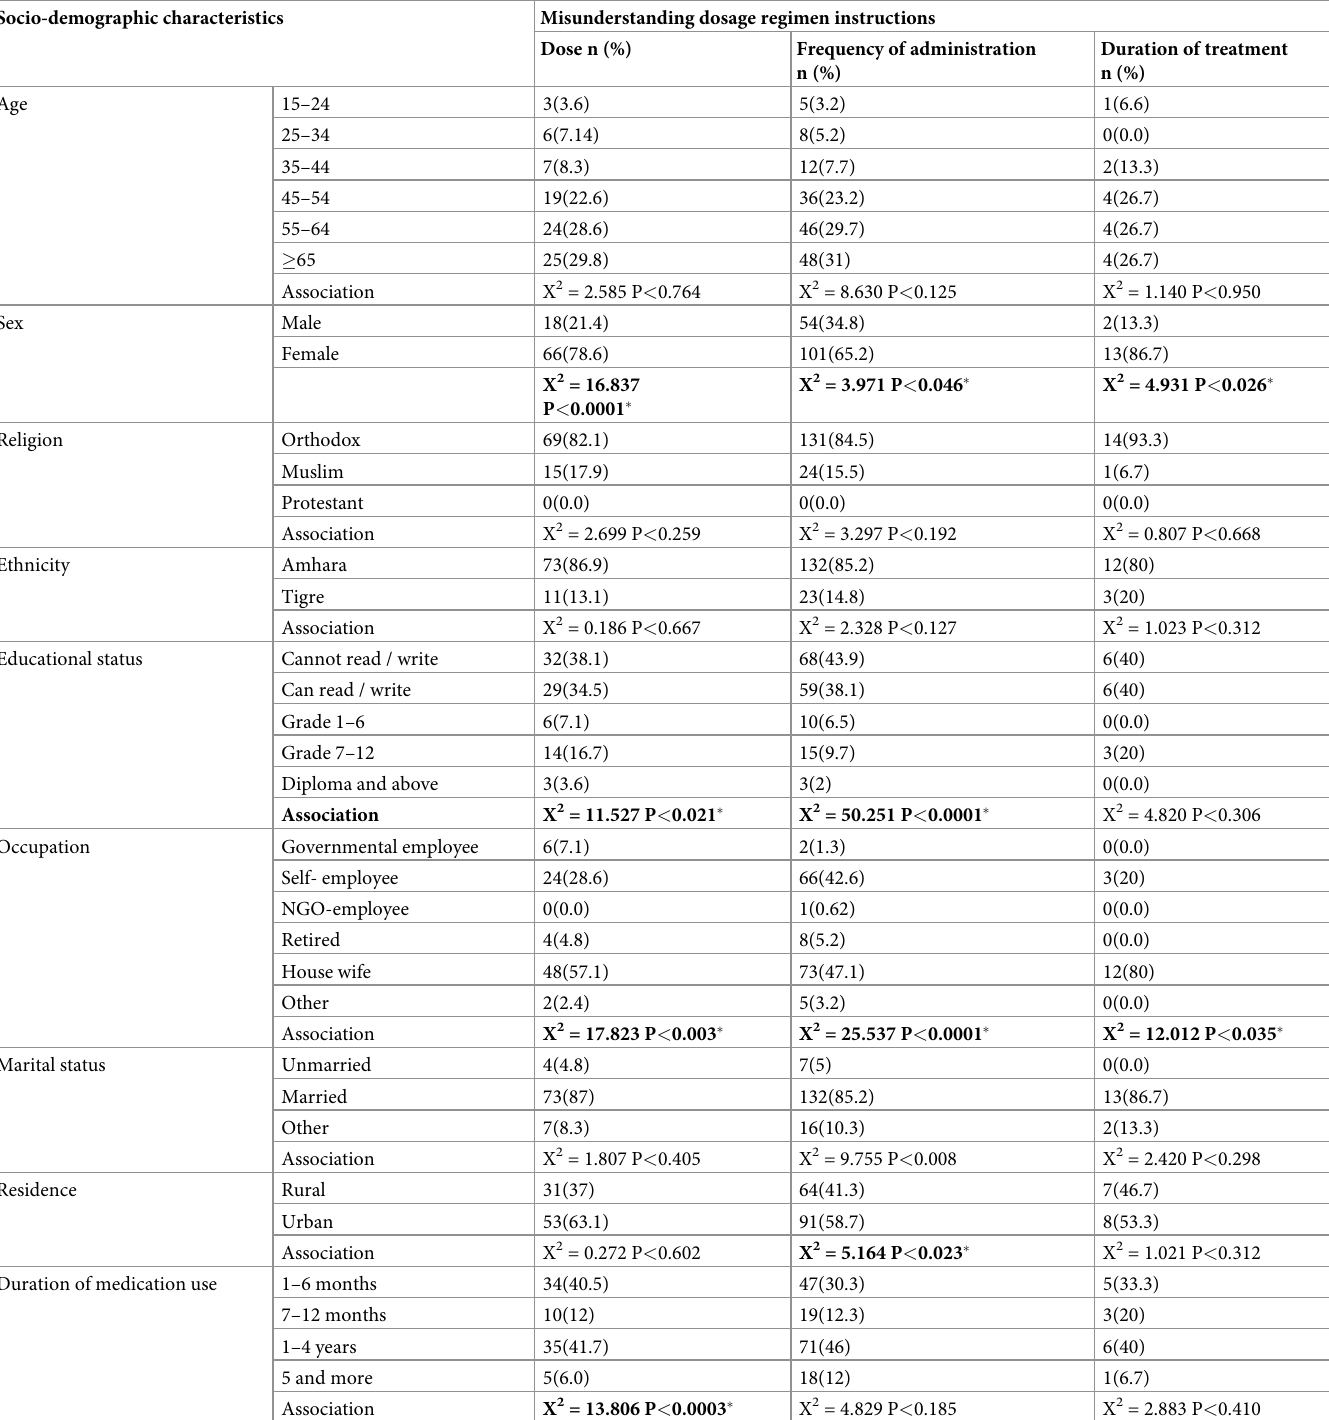
Table 3. Misunderstanding of dosage regimen instructions stratified by socio-demographic characteristics. Socio-demographic